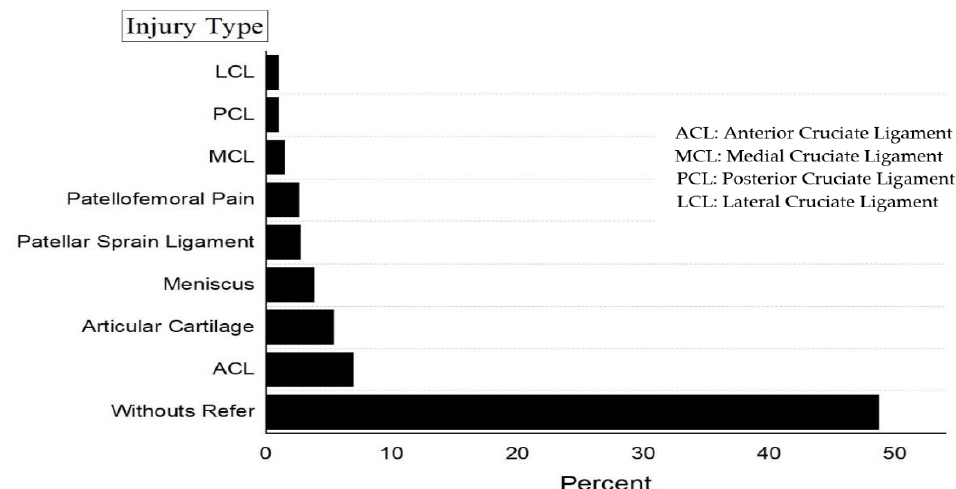
Figure 1. Flowchart of participants included in the study.